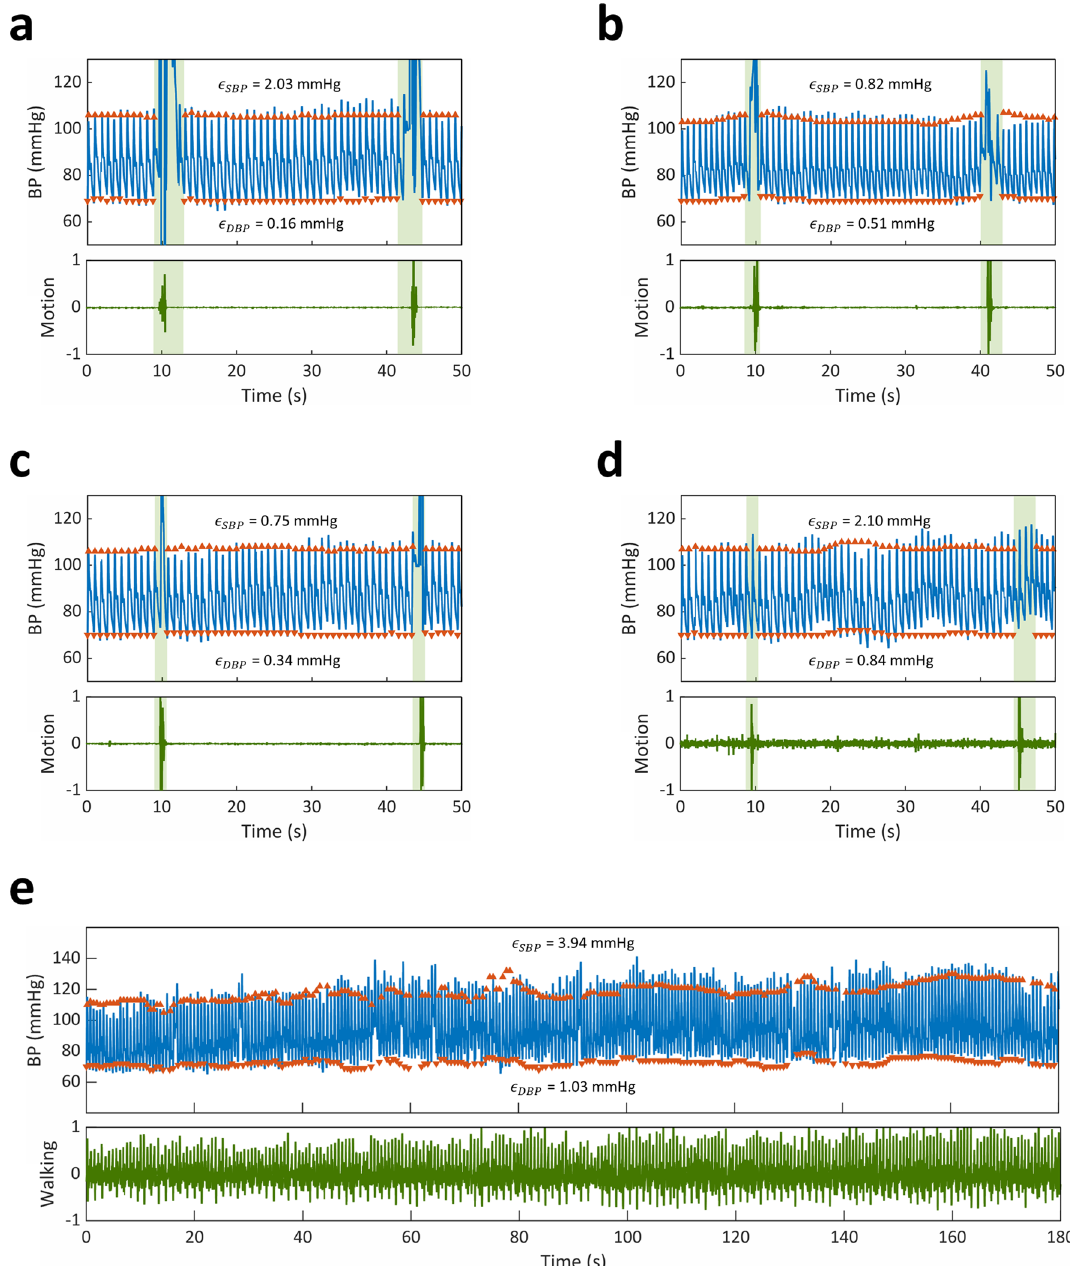
Figure 6. Measurement performance in ambulatory BP monitoring. CAP sensor (blue line) and Caretaker (orange arrows) BP measurements with corresponding normalized accelerometer signal (green line) during ( a ) 180° wrist rotation, ( b ) 90° wrist flexion, ( c ) hand closure, ( d ) wrist hit/impulse, and ( e ) walking. ( a – d ) Green shaded regions indicate periods of movement. Upward and downward facing arrows represent Caretaker SBP and DBP,